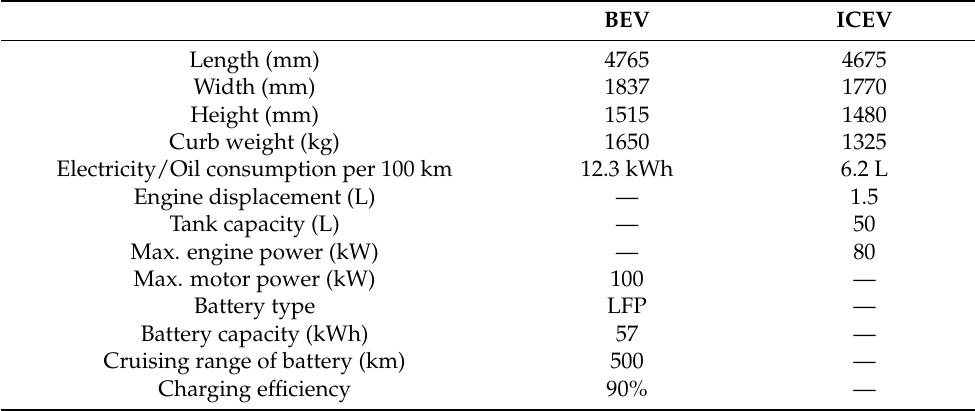
Table 2. Characteristics of the reference BEV and ICEV